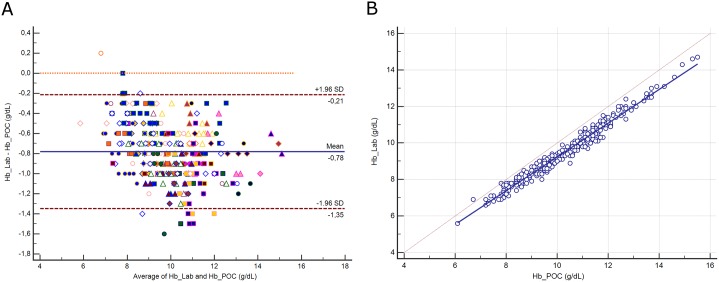
6A. Bland-Altman plot showing the difference versus the average of hemoglobin (Hb) measured by the central Lab analyzer and by the POC Siemens RAPIDPoint 500 blood gas system. Bias, upper and lower limits of agreement (±1.96 SD) are represented. The red dotted line indicates equality (difference = 0). There is one marker for each patient. 6B. Scatter diagram showing Deming regression analysis for hemoglobin (Hb) measured by the central Lab analyzer and by the POC Siemens RAPIDPoint 500 blood gas system. The regression line (solid line) and the identity line (x = y, dotted line) are represented.